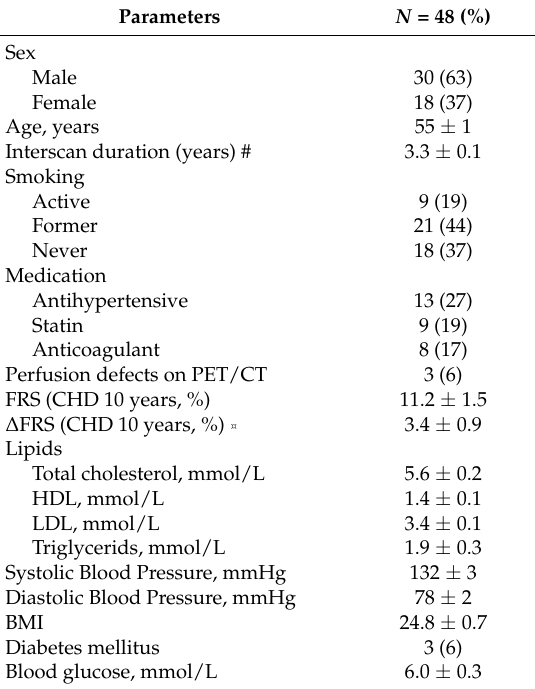
Table 1. Baseline characteristics of the patients.